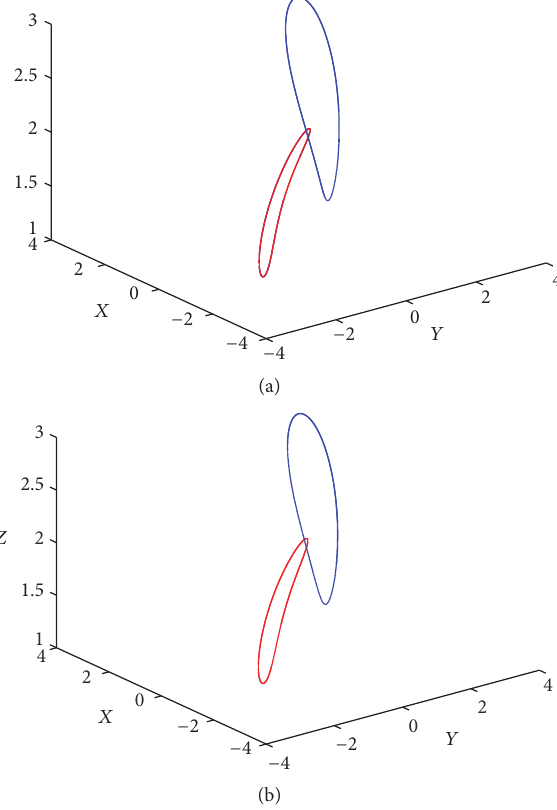
Figure 4: Coexisting limit cycles in the proposed system. (a) {𝑎 = 24 , 𝑏 = 2 , 𝑐 = 3 , and 𝑑 = 10} and (b) {𝑎 = 20 , 𝑏 = 2 , 𝑐 = 3 , and 𝑑 = 10.55} . Initial conditions: (1,1,1,1) and (−2,−2,−2, −2)